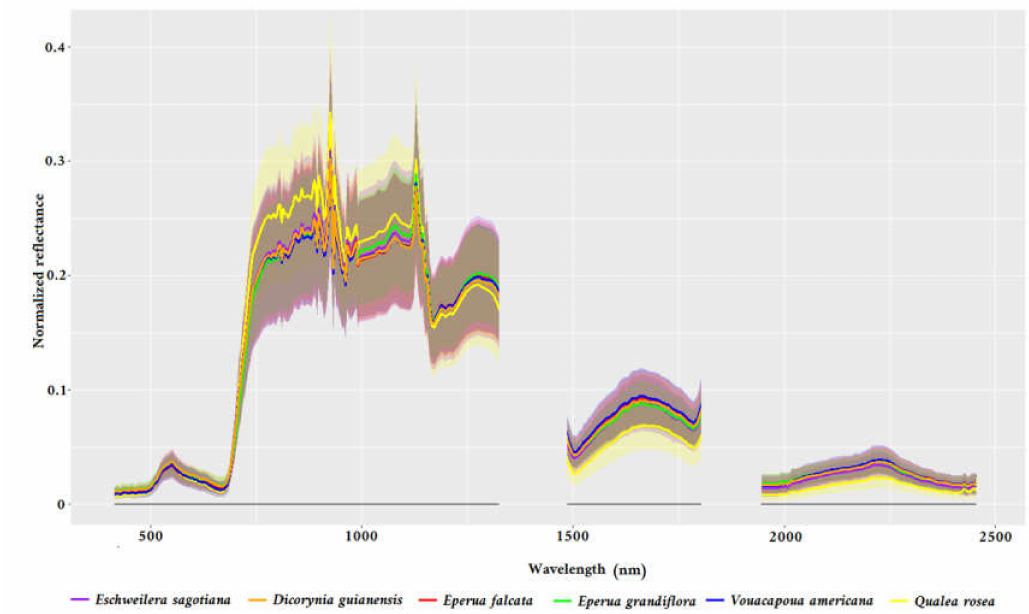
Figure 2. Normalized mean reflectance spectra (and standard deviation) for six focal species estimated on manually segmented